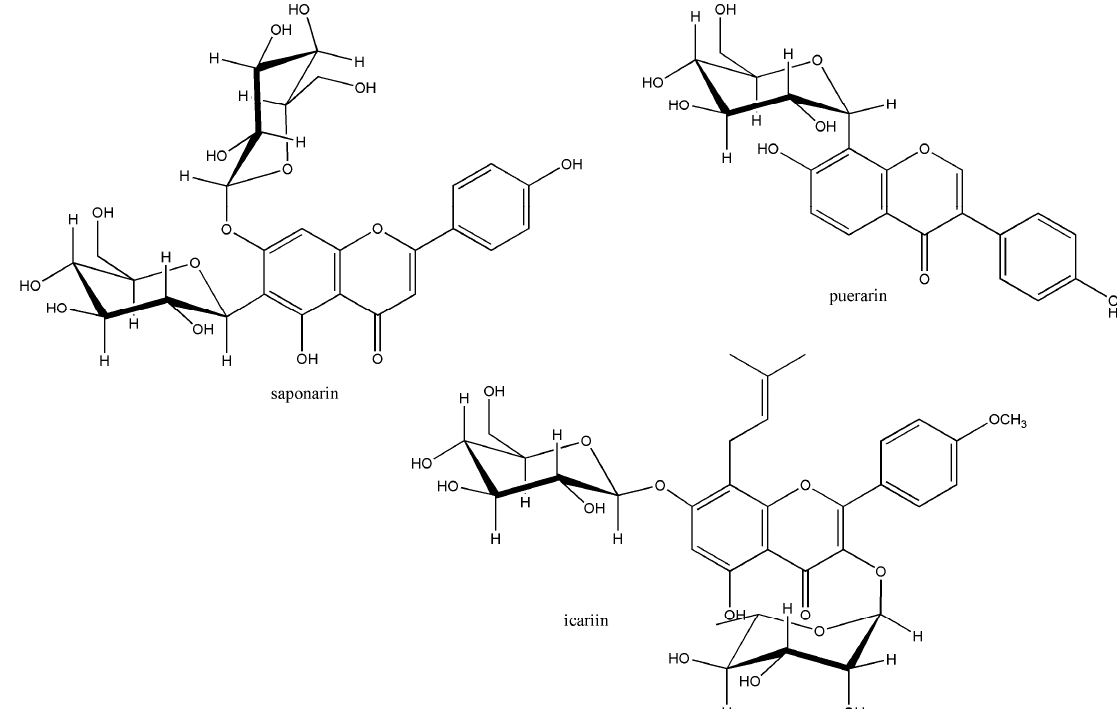
Figure 6. Molecular structures of selected C -glucoside and prenylated flavonoids.